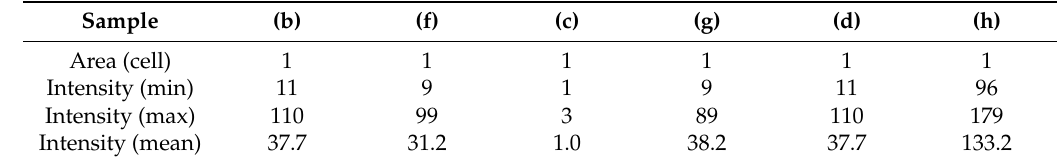
Table 3. The fluorescence brightness of the selected cell.